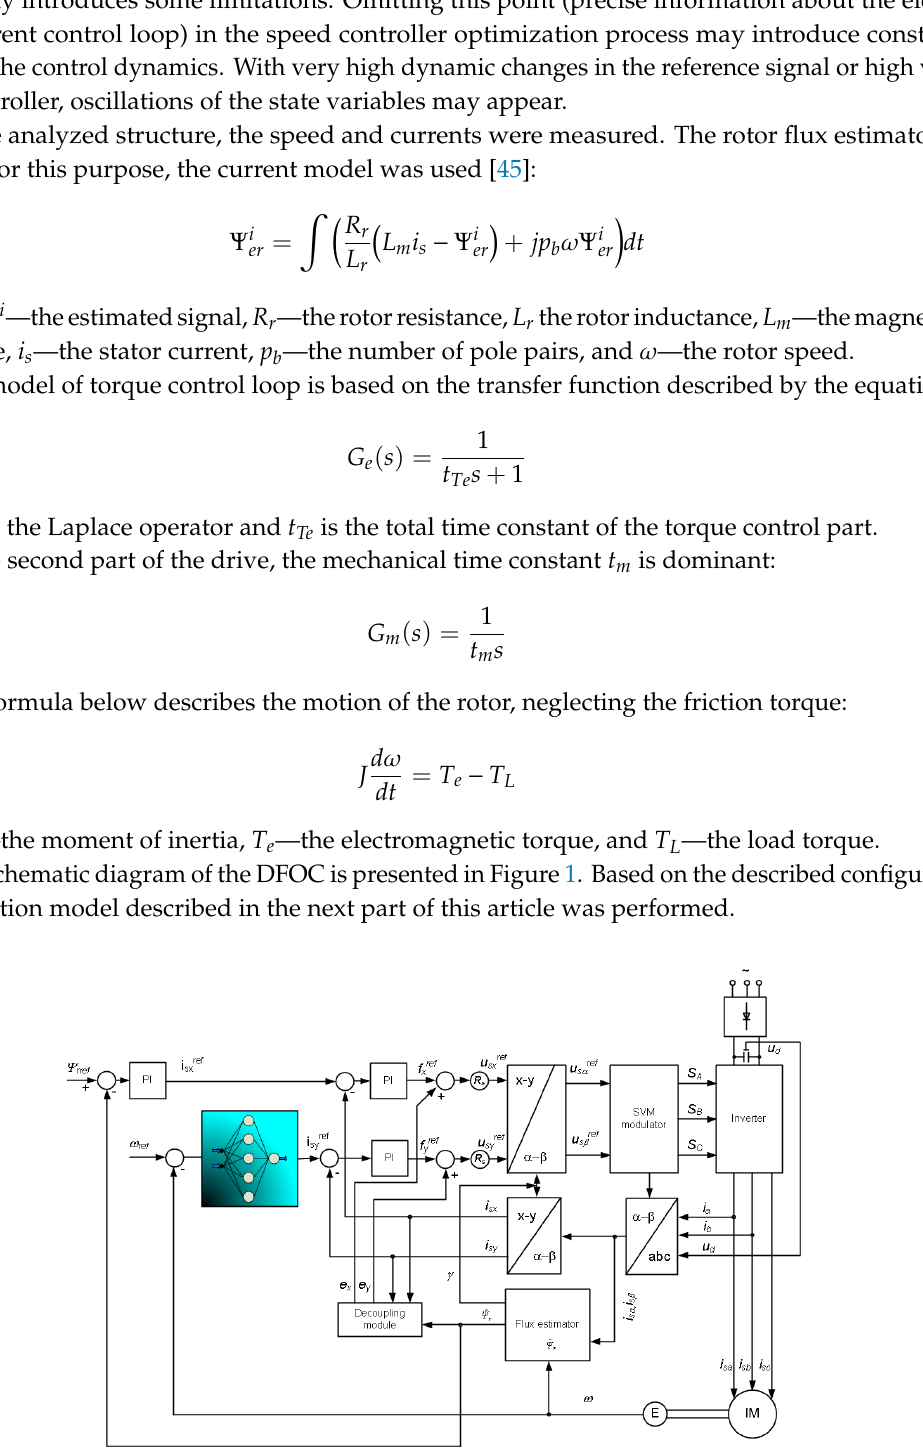
Figure 1. The Direct Field Oriented Control with neural speed controller.